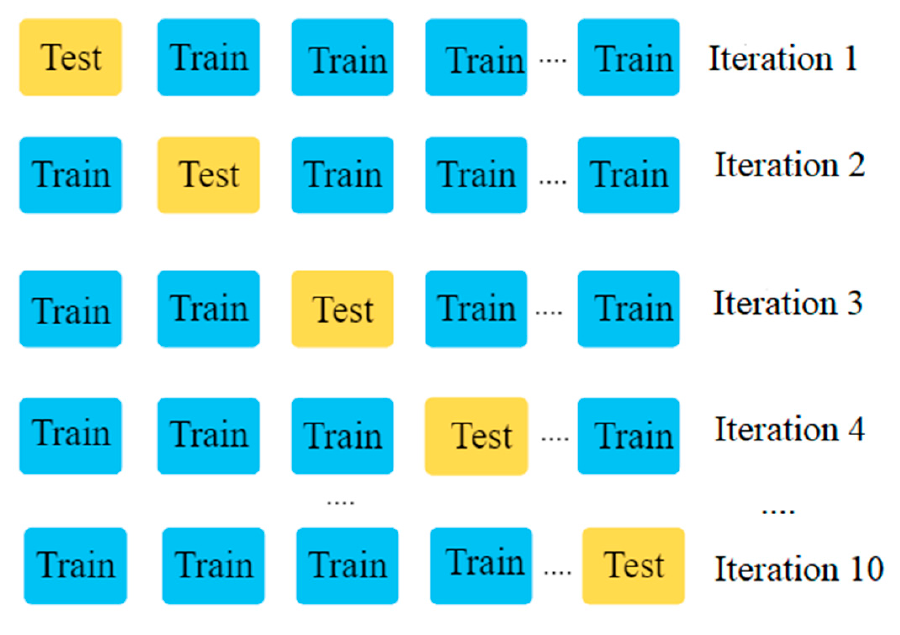
Figure 4. K-fold (10-fold) cross-validation process [55].